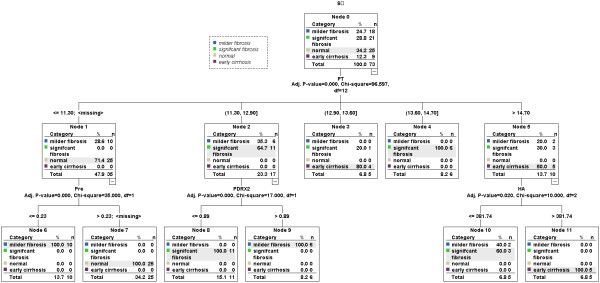
Decision tree for the differentiation of various stages fibrosis using four serological markers. Briefly, in a training group of 73 samples, samples were first divided into three groups (normal & milder fibrosis, milder & significant fibrosis, significant fibrosis & early cirrhosis) by marker "PT" (cutoff value = 12.00, 13.60 and 14.70, respectively); The normal & milder fibrosis group was then correctly classified by marker "Pre" (cutoff value = 0.23); the milder & significant fibrosis group was then correctly classified by marker "Prx II" (cutoff value = 0.80); the significant fibrosis & early cirrhosis group was then classified by marker "HA" (cutoff value = 381.74) and all the early cirrhosis samples (9/9) were correctly classified. The correct prediction percentage of the algorithm for normal control, milder fibrosis, significant fibrosis and early cirrhosis was 100%, 88.9%, 95.2% and 100%, respectively.